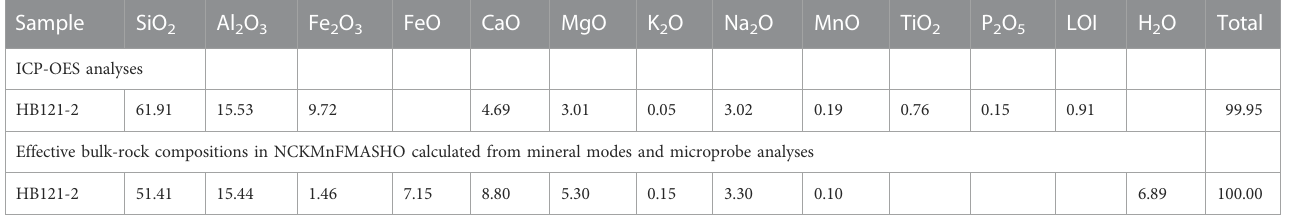
TABLE 1 Bulk-rock major element composition of the Si-rich eclogite from the Western Tianshan (wt%).